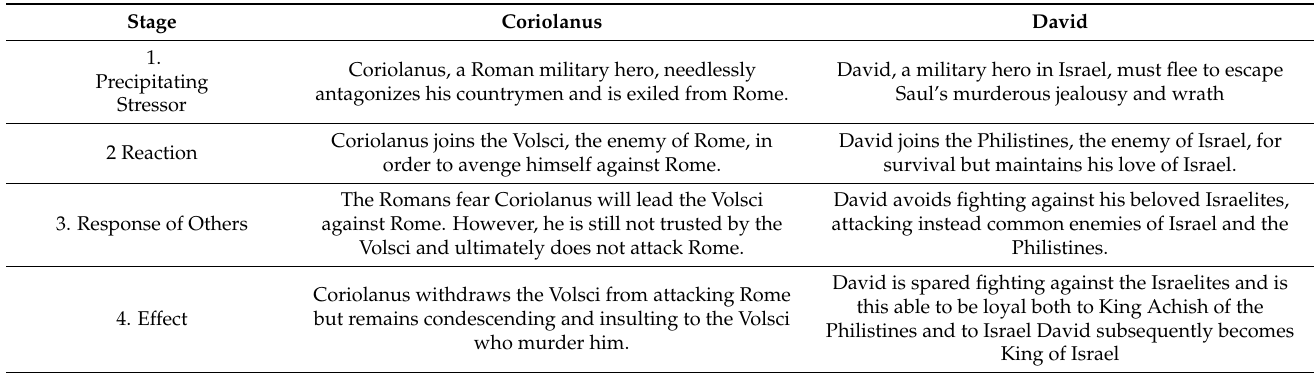
Table 6. . David against